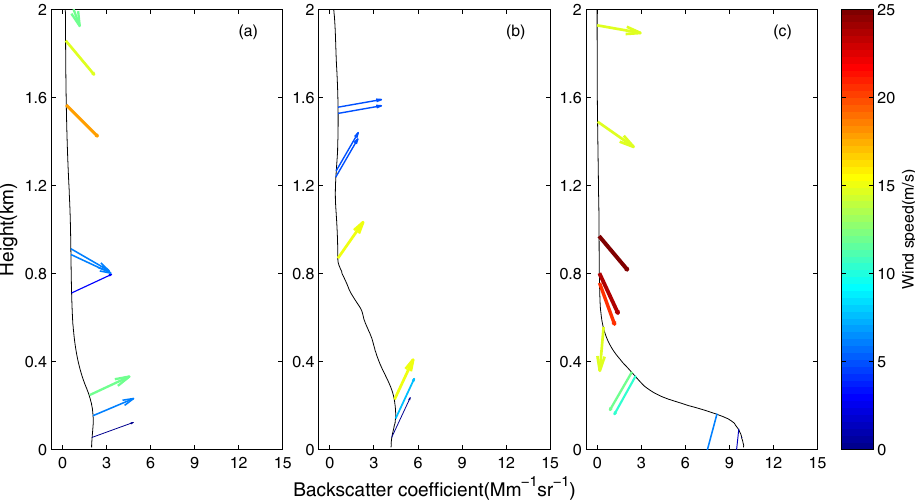
Figure 14. Attenuated backscattering coefficients and wind vectors for 17–21 November at (a) 20:00LT on 17 November, (b) 20:00LT on 18 November, and (c) 20:00LT on 21